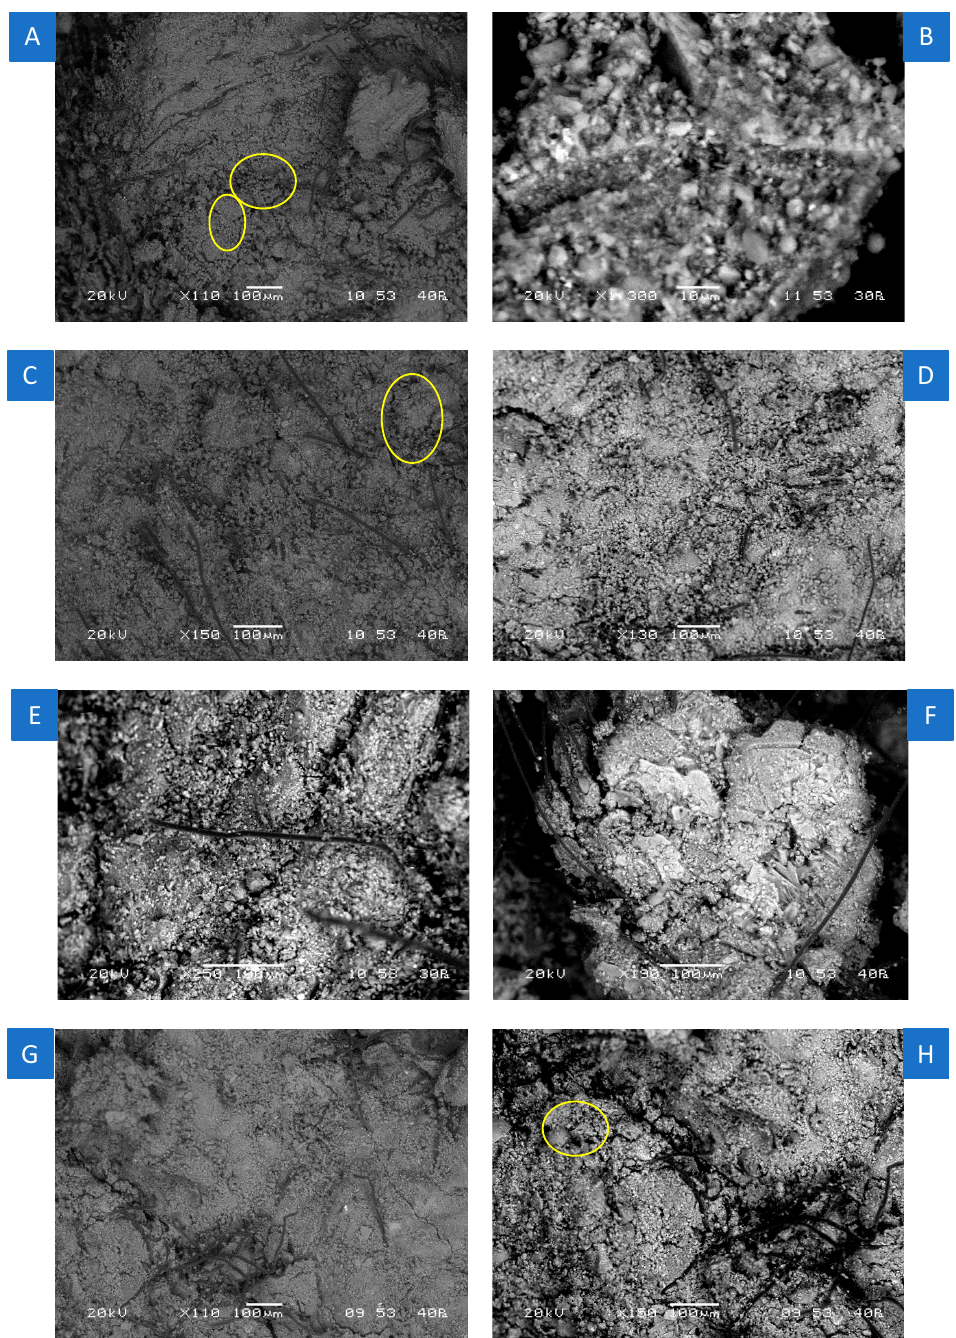
Figure 13. Backscattered scanning electron microscopy imaging (BSE) micrograph of ( A ) F.PC60LS20FA20PVA3SP2 at 110× magnification ( B ) F.PC60LS19FA20PVA3SP2 + 1% nC1 at 1300× magnification, ( C ) F.PC60LS19FA20PVA3SP2 + 1% nC2 at 150× magnification, ( D ) F.PC60LS16FA20PVA3SP2 + 4% nC1 at 130× magnification, ( E ) of F.PC60LS16FA20PVA3SP2 + 4% nC1 at 250× magnification, ( F ) of F.PC60LS16FA20PVA3SP2 + 4% nC1 at 190× magnification, ( G ) F.PC60LS16FA20PVA3SP2 + 4% nC2 at 110× magnification and ( H ) F.PC60LS16FA20PVA3SP2 + 4% nC2 at 150× magnification.